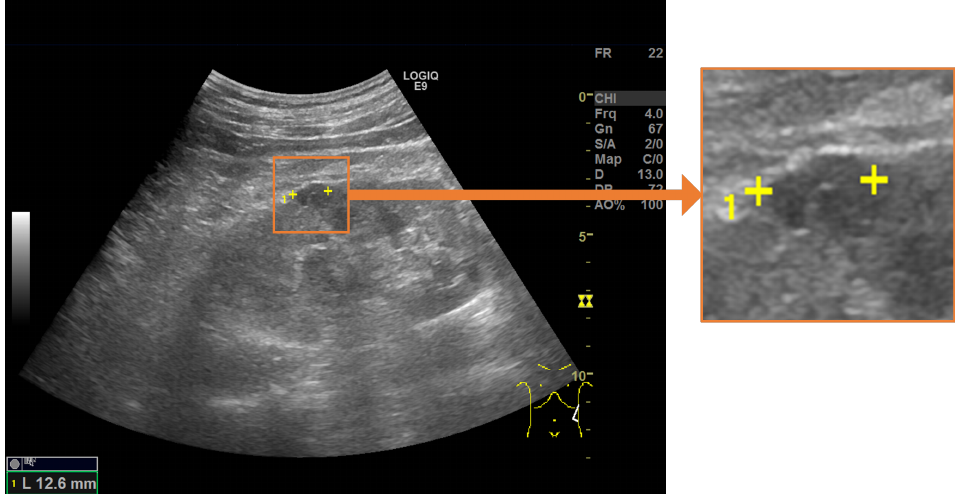
Figure 1. Salient landmarks placed on a renal cyst. A pair of salient landmarks are placed on the longest diameter of the renal